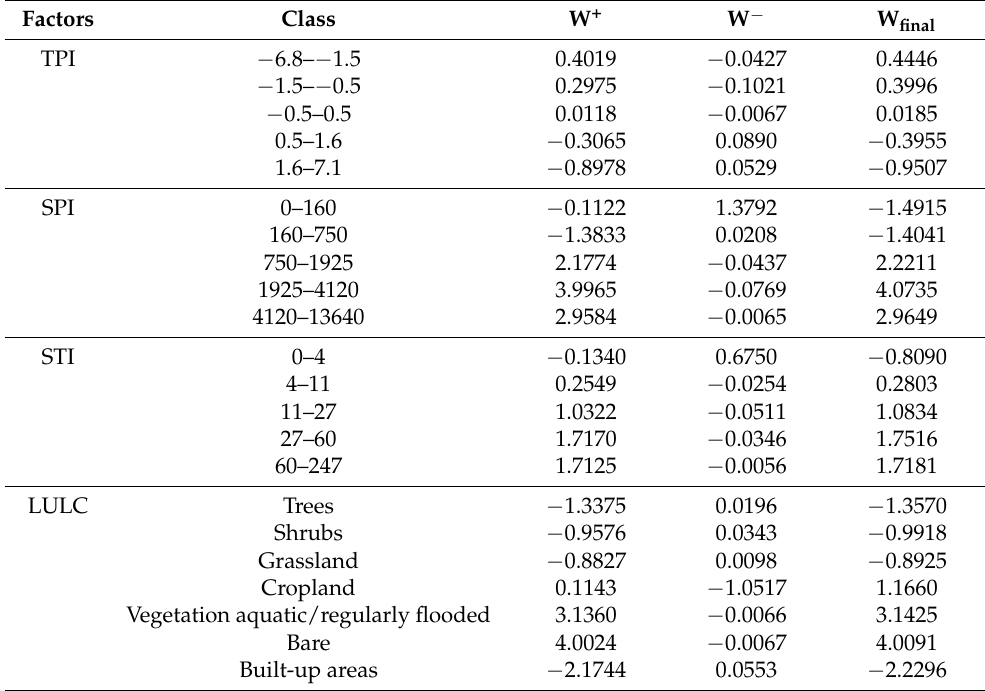
Table 3. Weights of conditioning factors TPI, SPI, STI, LULC as analyzed using WoE method.